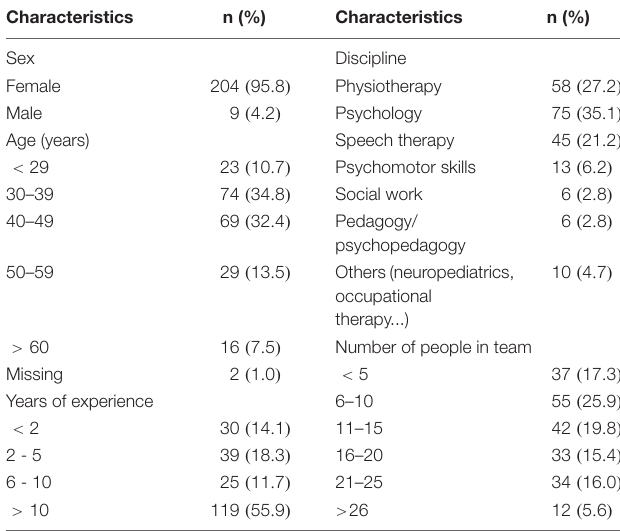
TABLE 2 | Demographic characteristics of professionals ( n =